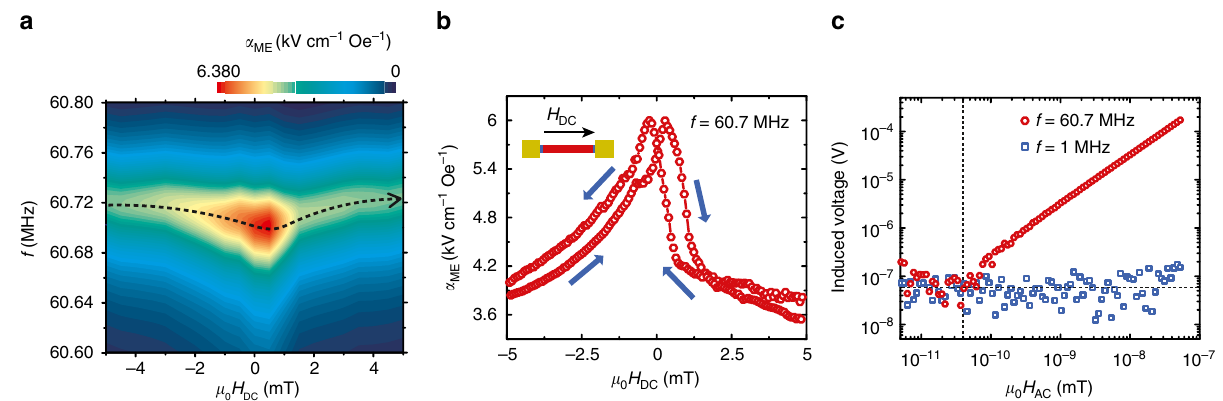
Fig. 2 Bias magnetic fi eld and frequency dependence. a Magnetoelectric (ME) coupling coef fi cient α ME of ME NPR as functions of DC bias magnetic fi eld H DC ( x -axis) and the frequency of RF magnetic fi eld ( y -axis). The dashed curve exhibits the resonance frequency (highest intensity at each frequency sweep) versus the bias magnetic fi eld. The bias magnetic fi eld was swept from − 5 to 5 mT. b The hysteresis loop of α ME obtained by sweeping the magnetic fi eld back and force at f = 60.7 MHz. The inset shows the schematic representation of the ME NPR with the external bias magnetic fi eld applied along its length direction. c Induced ME voltage as a function of magnetic fi eld at excitation frequency of 60.7 MHz ( red ) and 1 MHz ( blue